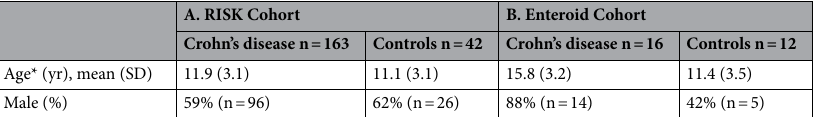
Table 1. Demographic data of cohorts used for metabolic modeling: A. RISK cohort. Publicly available Risk Stratification and Identification of Immunogenetic and Microbial Markers of Rapid Disease Progression in Children with Crohn’s Disease (RISK) cohort data was accessed using GEO accession series GSE57945. RISK is a prospective inception cohort study that enrolled 1,276 pediatric patients with IBD diagnosed at 28 sites in North America between 2008 and 2012. It includes n = 163 patients with ileal Crohn’s disease and n = 42 healthy controls. B. Enteroid cohort. Gene expression data for all mucosal terminal ileal biopsies used to generate enteroids included in this study have been accessed from the Sequence Read Archive (SRA) using the SRA series accession SUB7687325. *Age at diagnosis; SD: standard